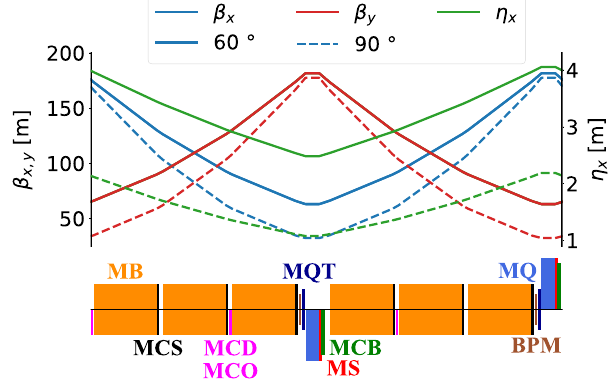
FIG. 19. LHC FODO cell together with the β functions and the dispersion function ( η ) for a 60° (solid line) and a 90° (dashed x line) design.